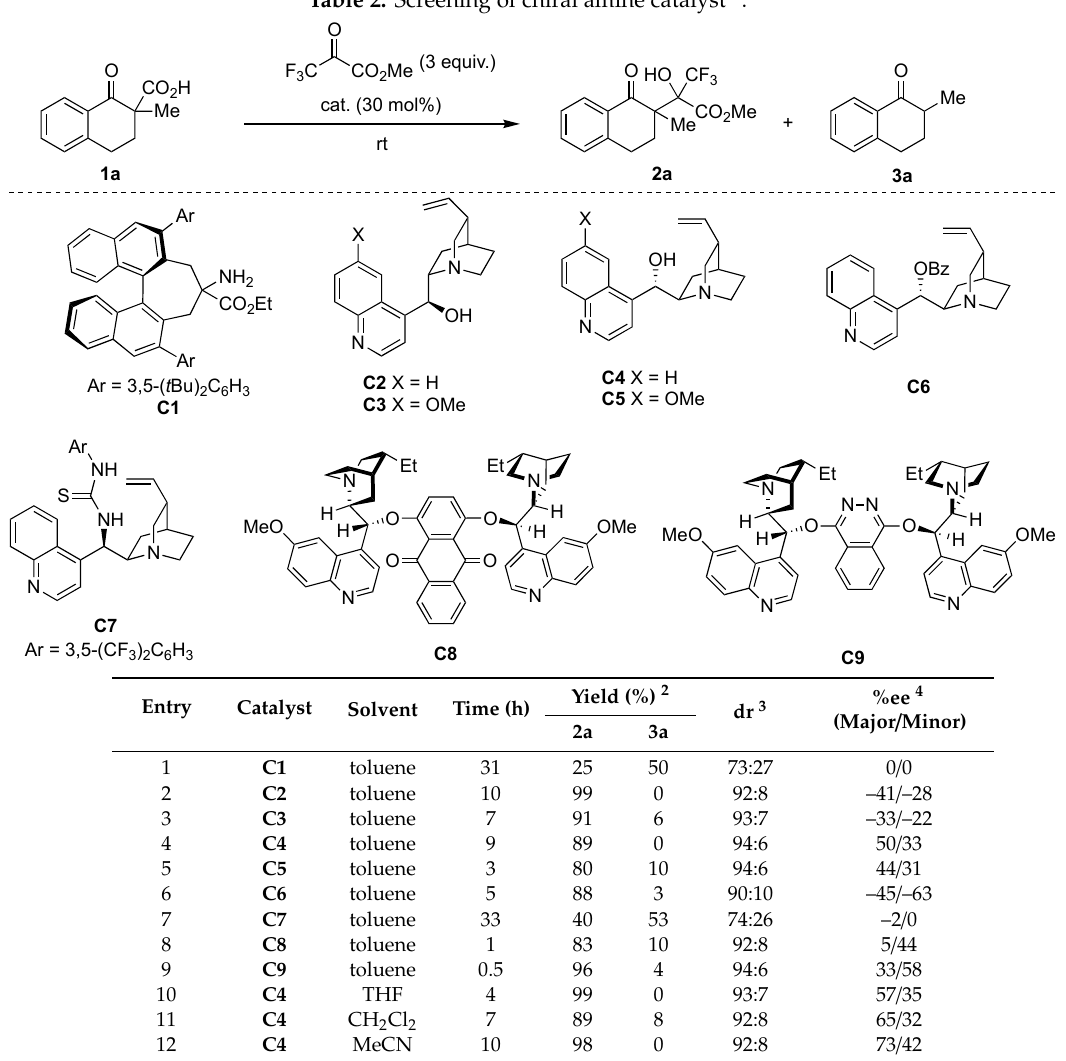
Table 2. Screening of chiral amine catalyst 1 .